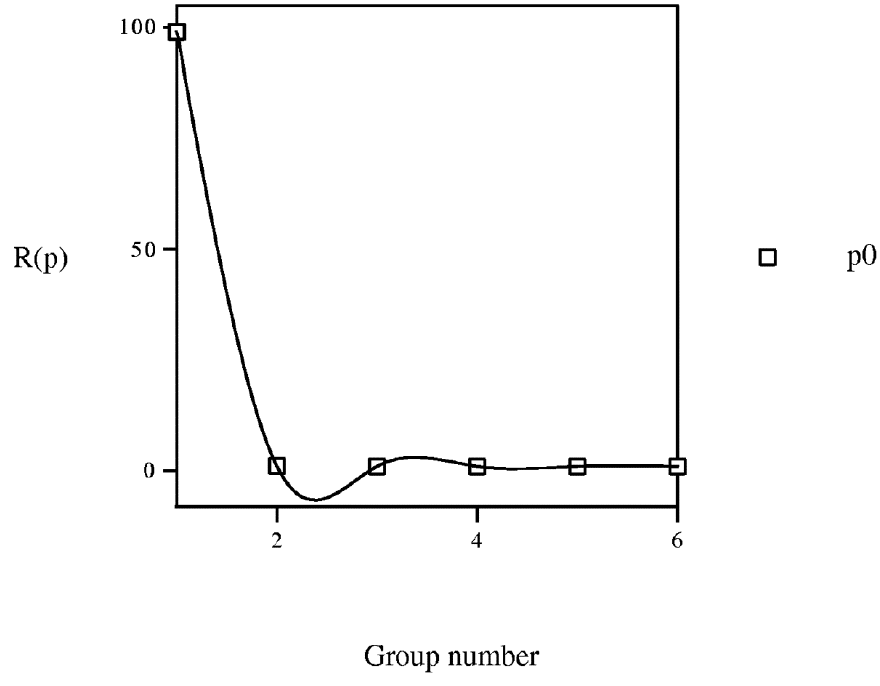
Figure 14. Variation of property R ( p ) = P ( p + 1)/ P ( p ) vs. group number. P : vector